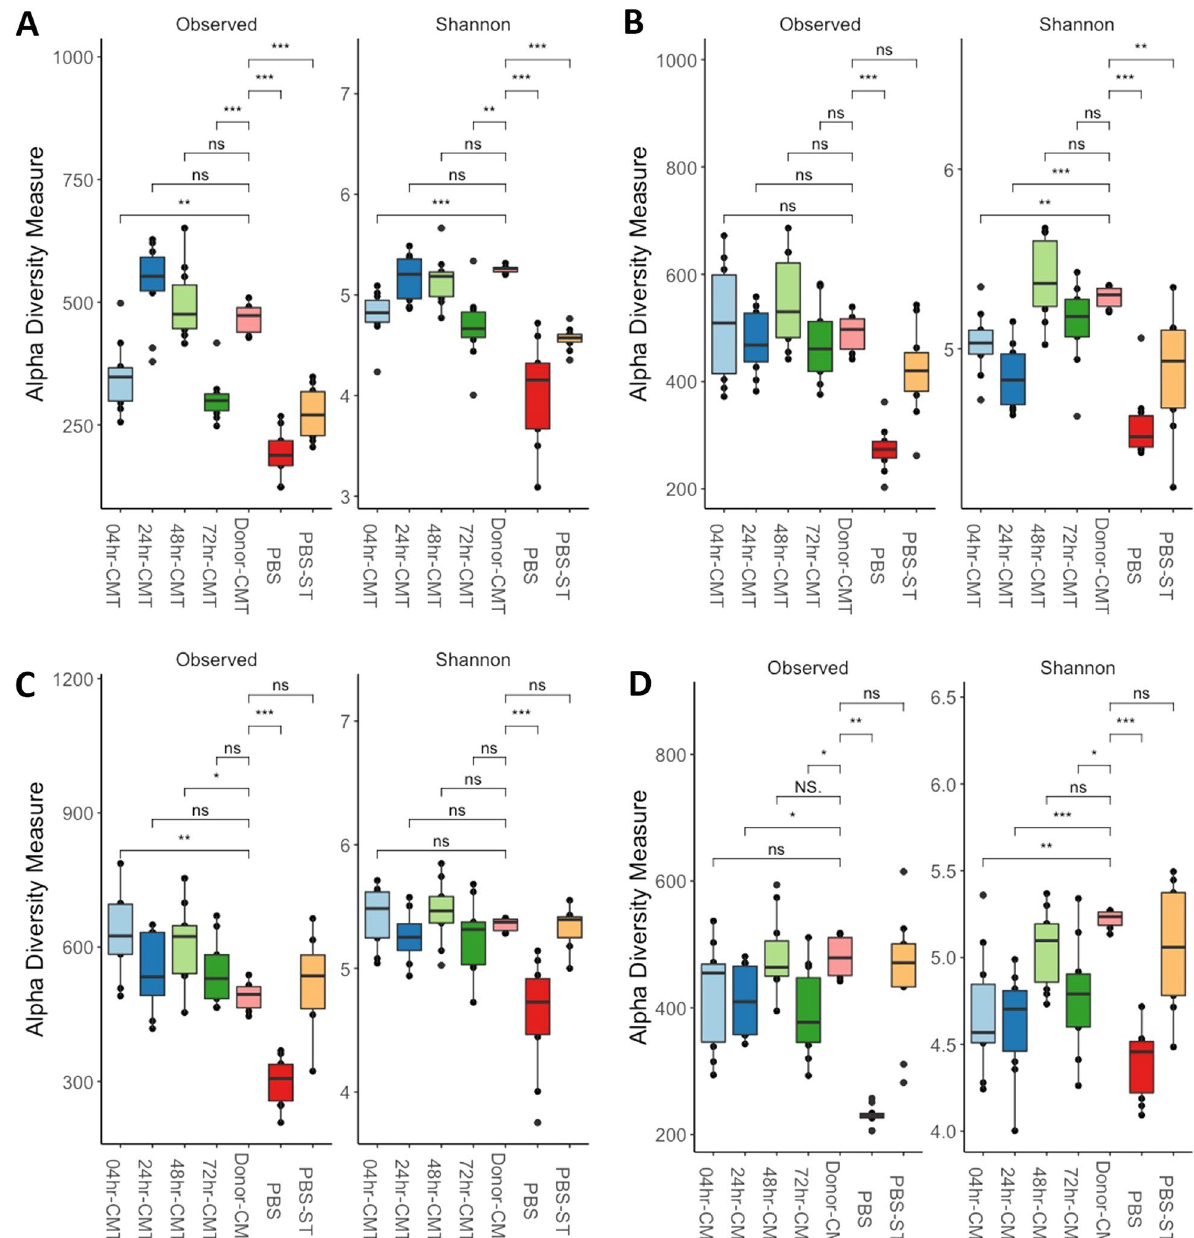
Fig. 4 Alpha diversity measures comparing timing effects on microbiome richness. Alpha diversity was calculated using Observed and Shannon measures at a sequencing depth of 7000. A At 7-dph and prior to infection with ST4/74 there were some differences noted in the observed species compared with donor-CMT. The CMT groups showed higher alpha diversity like the donor-CMT when compared with PBS groups. B At 3-dpi there is no significant difference in observed species of the CMT groups compared to the donor-CMT. Shannon diversity shows that CMT groups are still higher than PBS groups however alpha diversity of PBS-ST group appeared to be developing quicker than just PBS. C By 7-dpi the PBS-ST group was now as diverse in species abundance as the CMT and donor-CMT groups compared to PBS alone. D AT 14-dpi there is still higher diversity in the PBS-ST and the CMT groups compared to PBS alone groups suggesting that PBS group microbiota has not developed as quickly as the infected group. * P < 0.05, ** P < 0.01, *** P < 0.001, **** P < 0.0001 as determined by Wilcoxon non-parametric